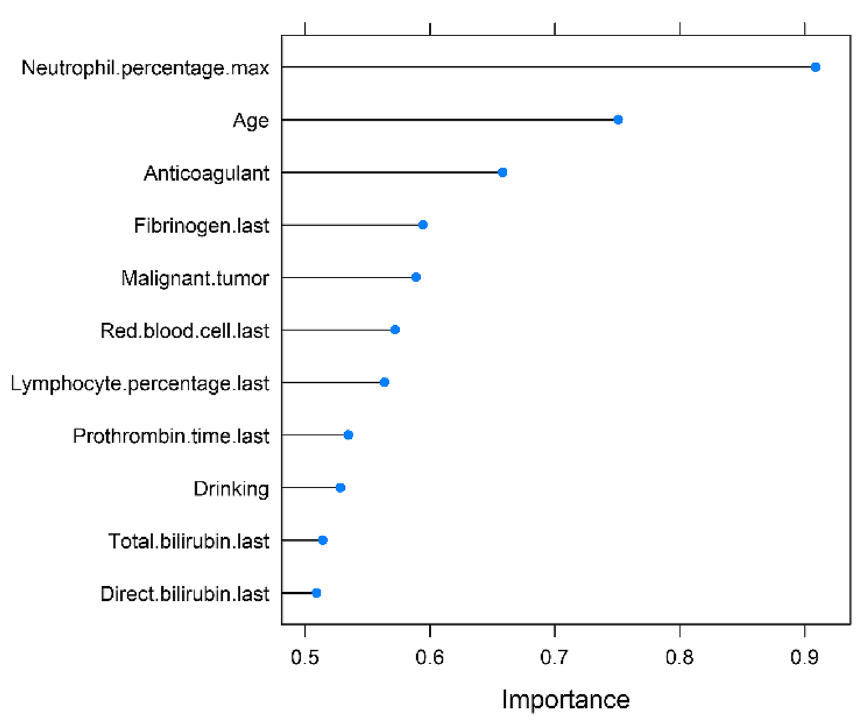
Figure 2. Ranking of the importance of variables in the model. Last: The last test results before the diagnosis of pulmonary embolism. Max: The maximum test results before the diagnosis of pulmonary